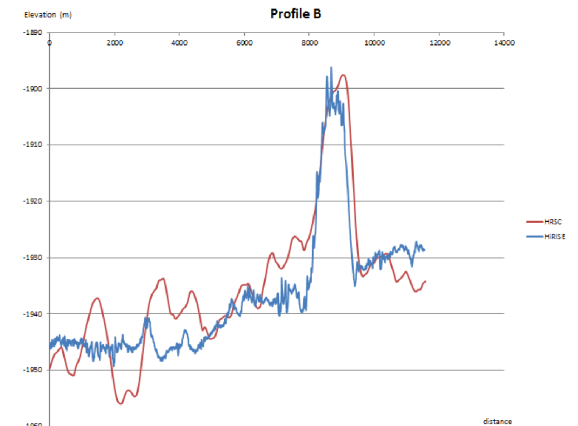
Figure 10. Profile B showing elevation of HiRISE (blue) and HRSC (red)